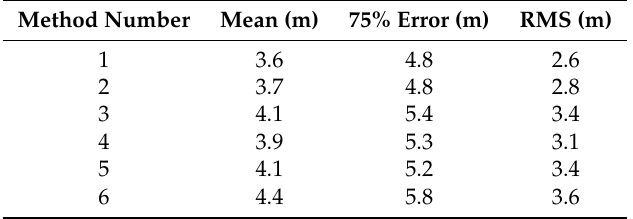
Figure 7. The CDFs of methods with different combinations for Building 2. The legends number correspondences can be found in Table 2. ( a ) CDFs ( b ) Enlarged CDFs. Table 3. The errors for different WLAN positioning methods for Building 1.